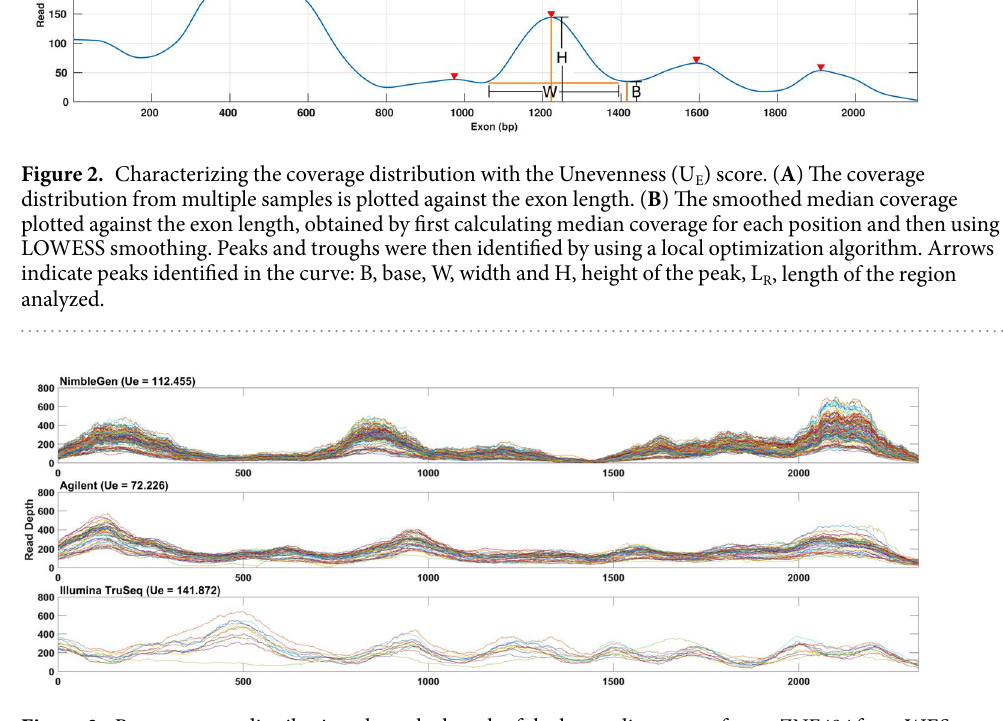
Figure 3. Base coverage distribution along the length of the last coding exon of gene ZNF484 from WES datasets obtained from ( A ) NimbleGen, ( B ) Agilent, and ( C ) Illumina TruSeq.